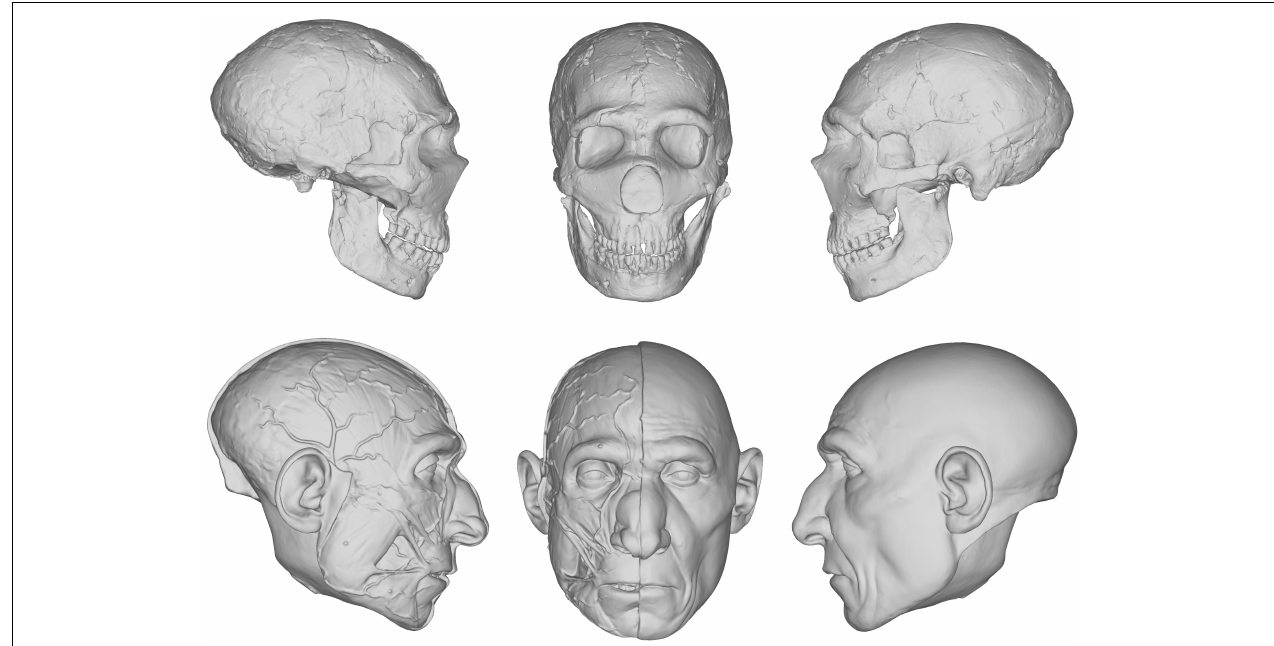
FIGURE 5 | Digital models showing the progression of the facial reconstruction procedure. Subject is based on a reconstruction of the Neanderthal Amud 1 cranium and associated mandible originally reconstructed by Suzuki and Takai (1970). Facial soft tissues were reconstructed using regression models developed in Simpson and Henneberg (2002) from modern human